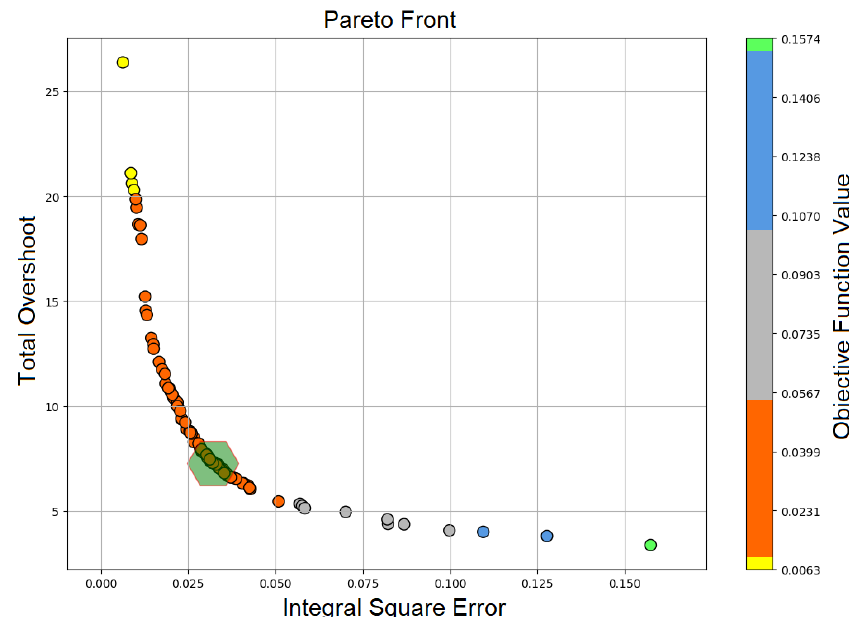
Figure 8. Pareto front of multi-objective optimization.